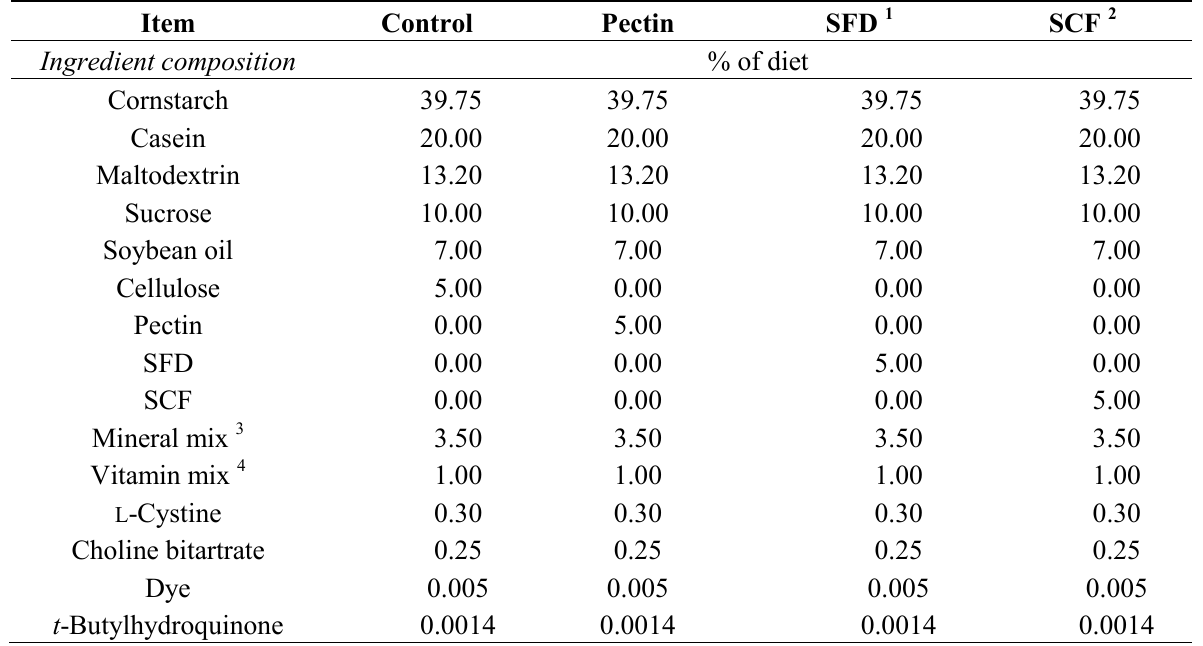
Table 1. Ingredient and chemical composition of diets containing select dietary fibers and fed to